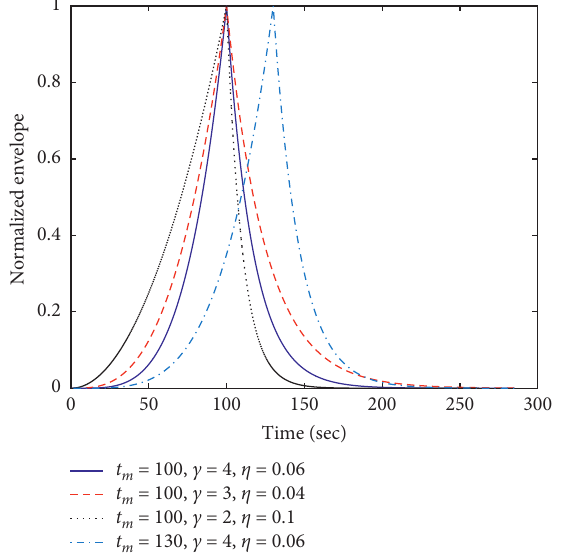
Figure 10: Piecewise function with various parameters of t η .